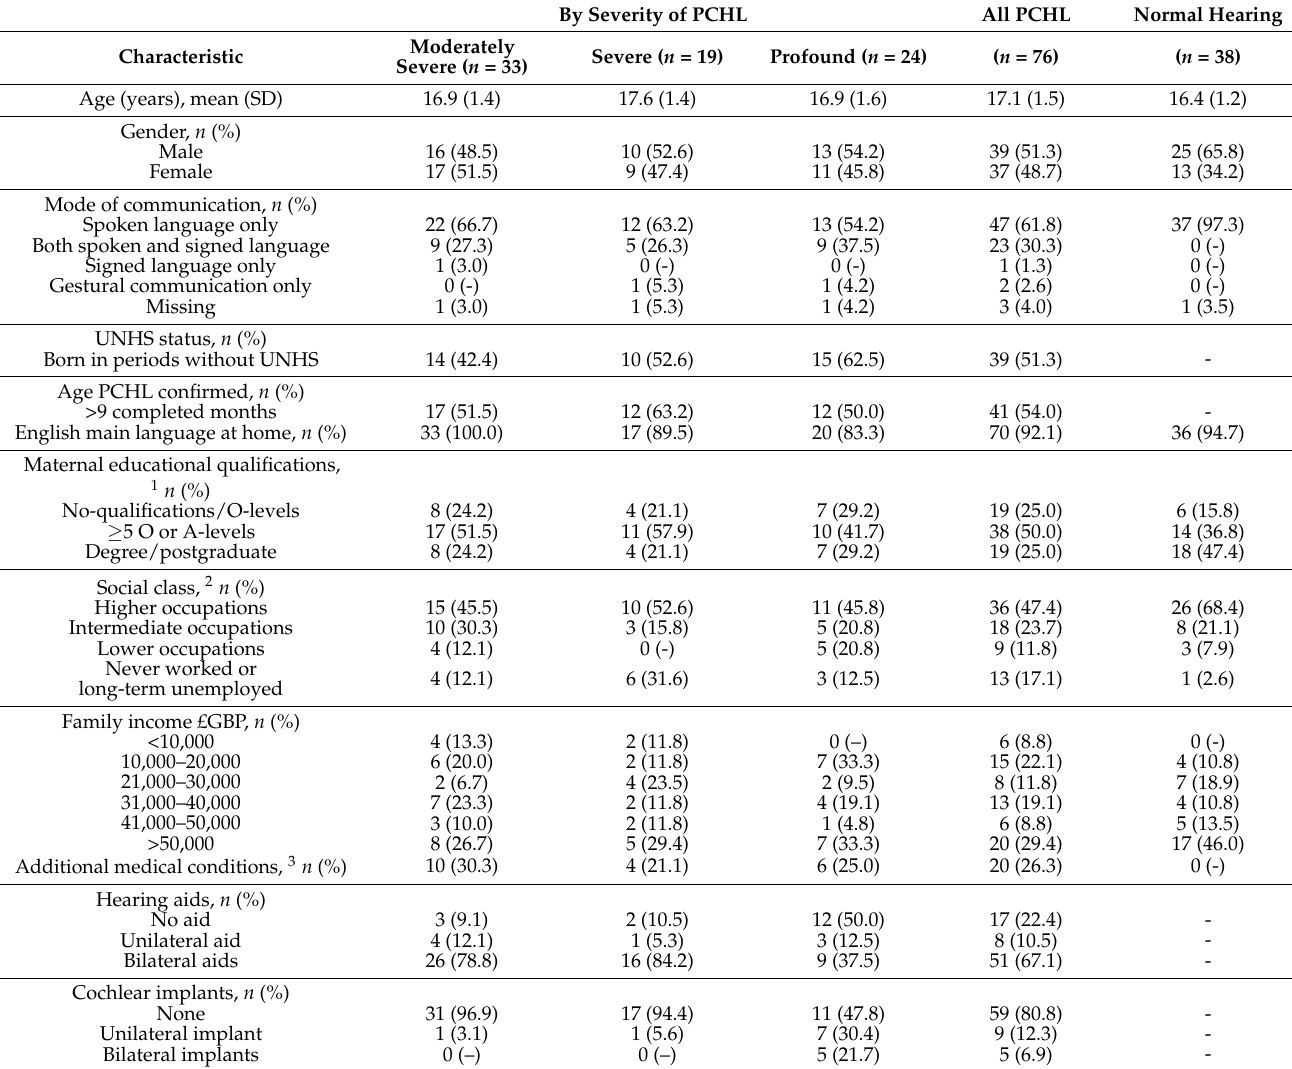
Table 1. Sociodemographic and clinical characteristics of study